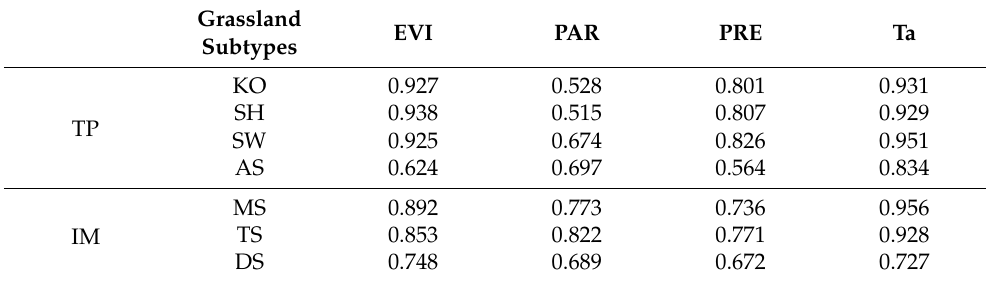
Table 4. The seasonal dynamic correlation (R 2 ) between RE and environmental variables in each grassland subtype.